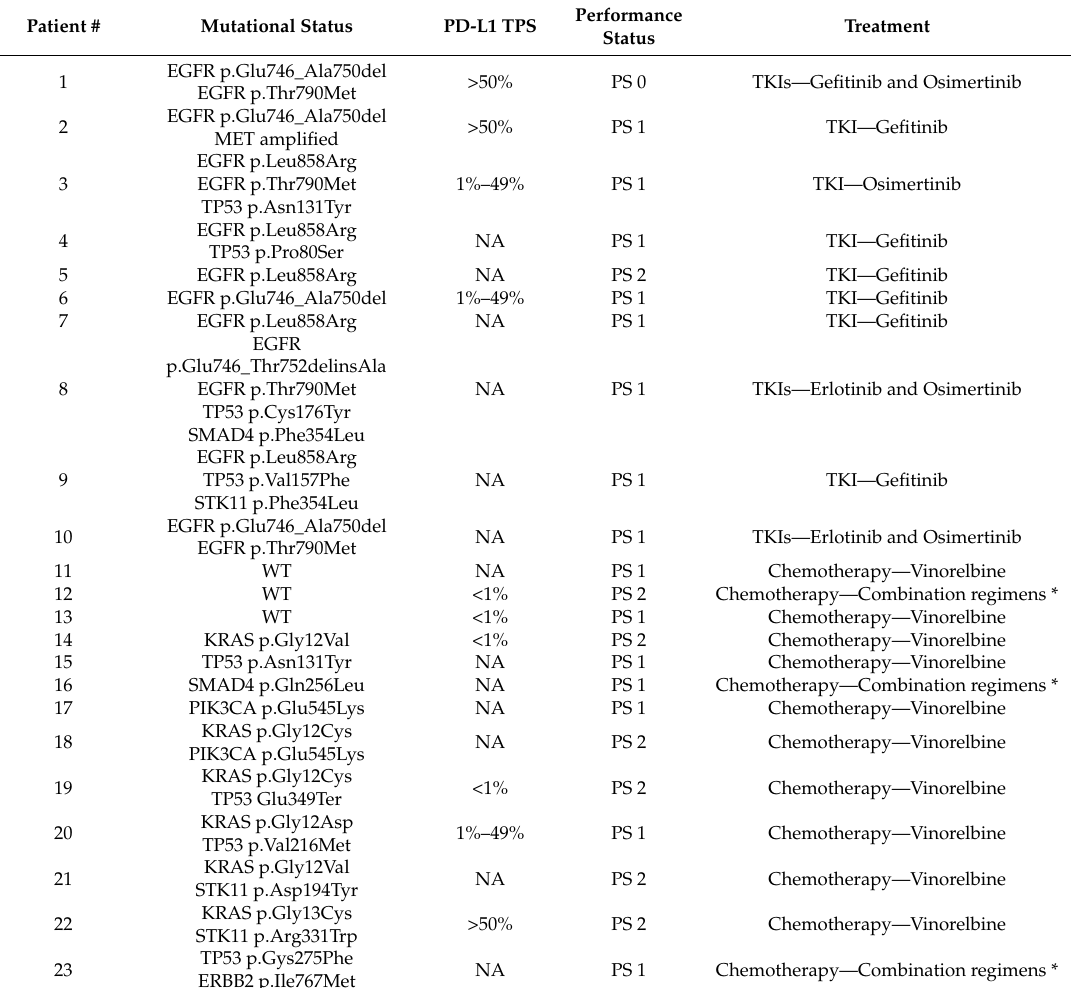
Table 3. Clinical and molecular characteristics of the 23 inpatients who received active